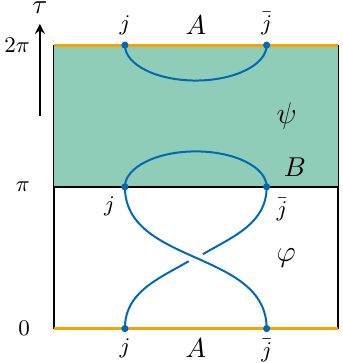
for the case with A